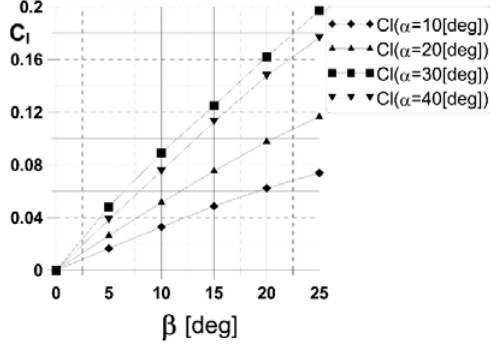
Fig. 15. Stability derivatives ∂C s /∂β – side force coefficients versus sideslip